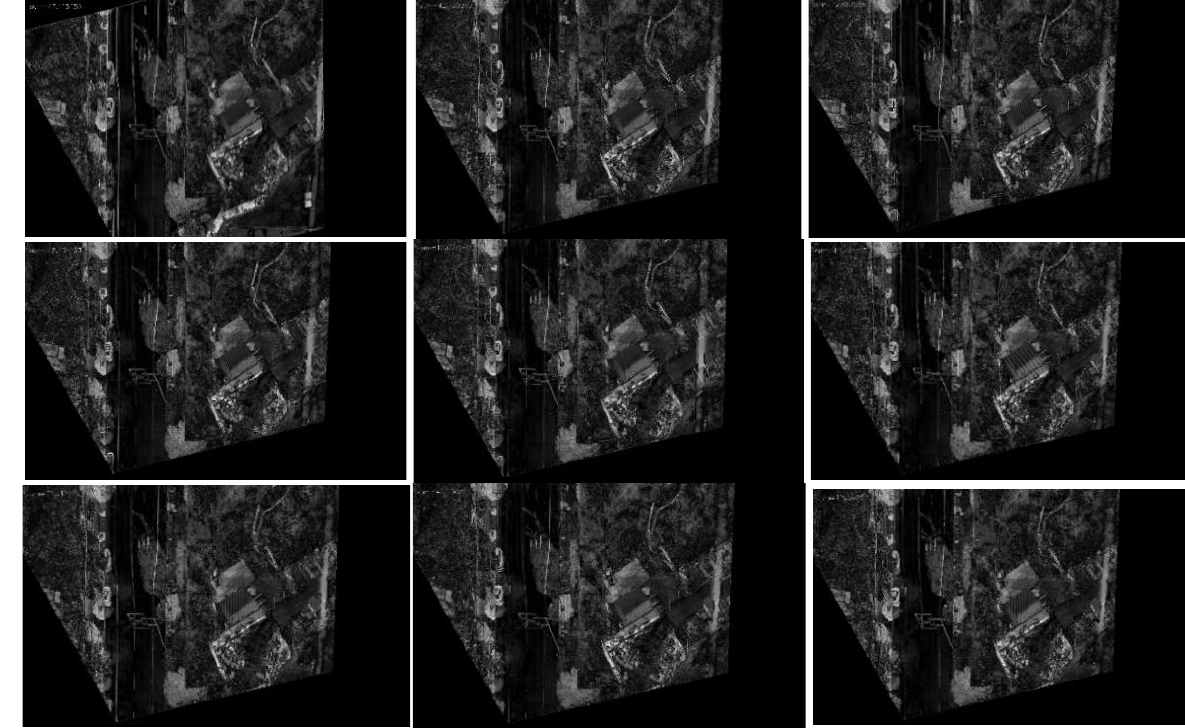
Figure 23. Registration difference image (after updating the map features).